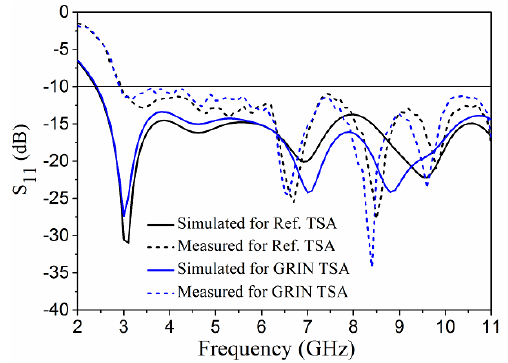
Figure 9: Reflection coefficient (S 11 ) of the reference (Ref.) and GRIN TSA